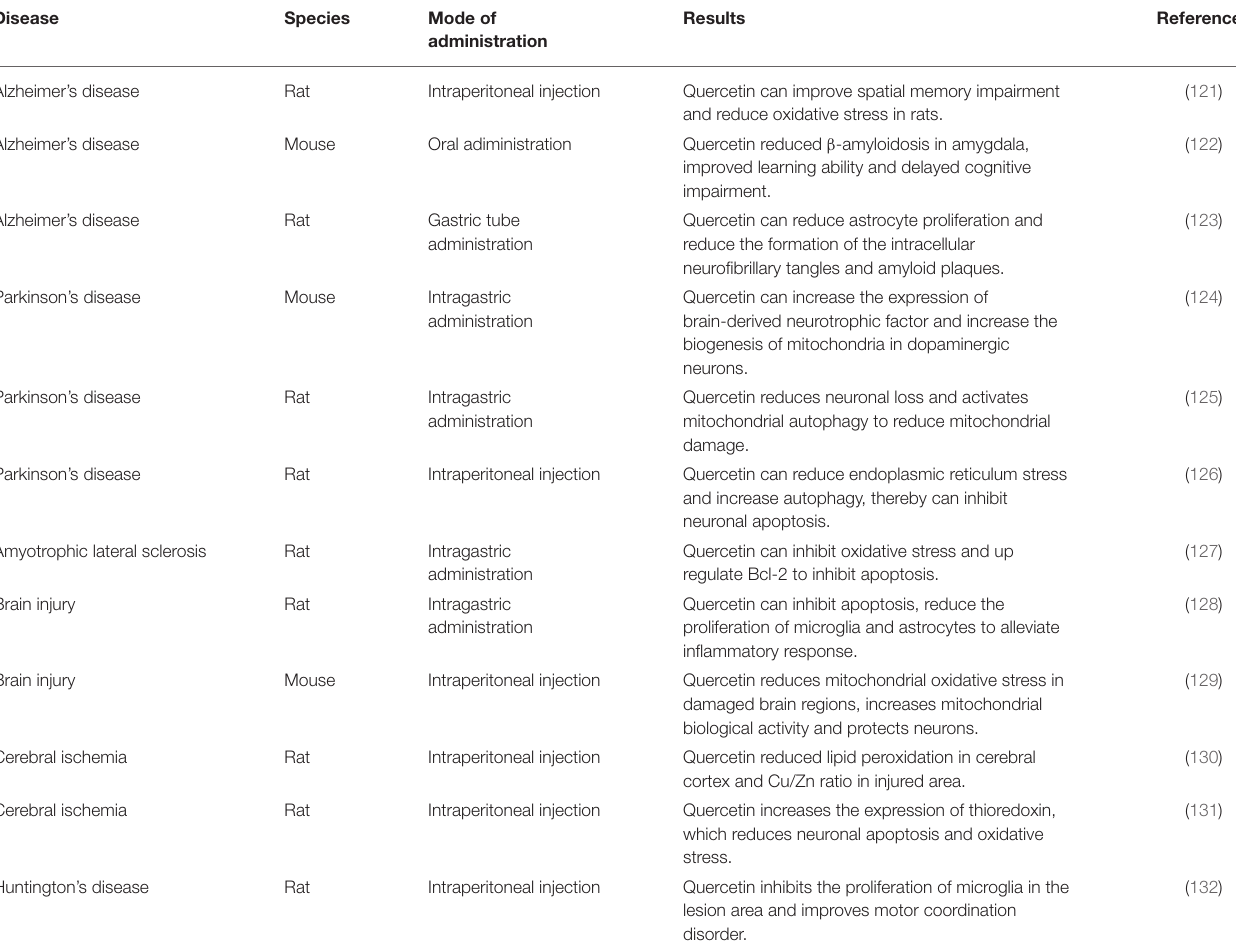
TABLE 1 | Therapeutic effect of quercetin on neurodegenerative diseases.